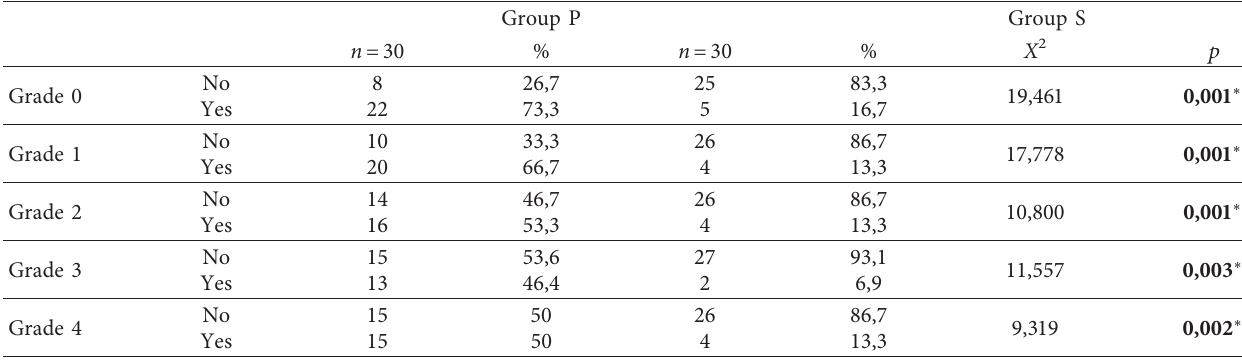
Table 7: Evaluation of intraoperative movements.